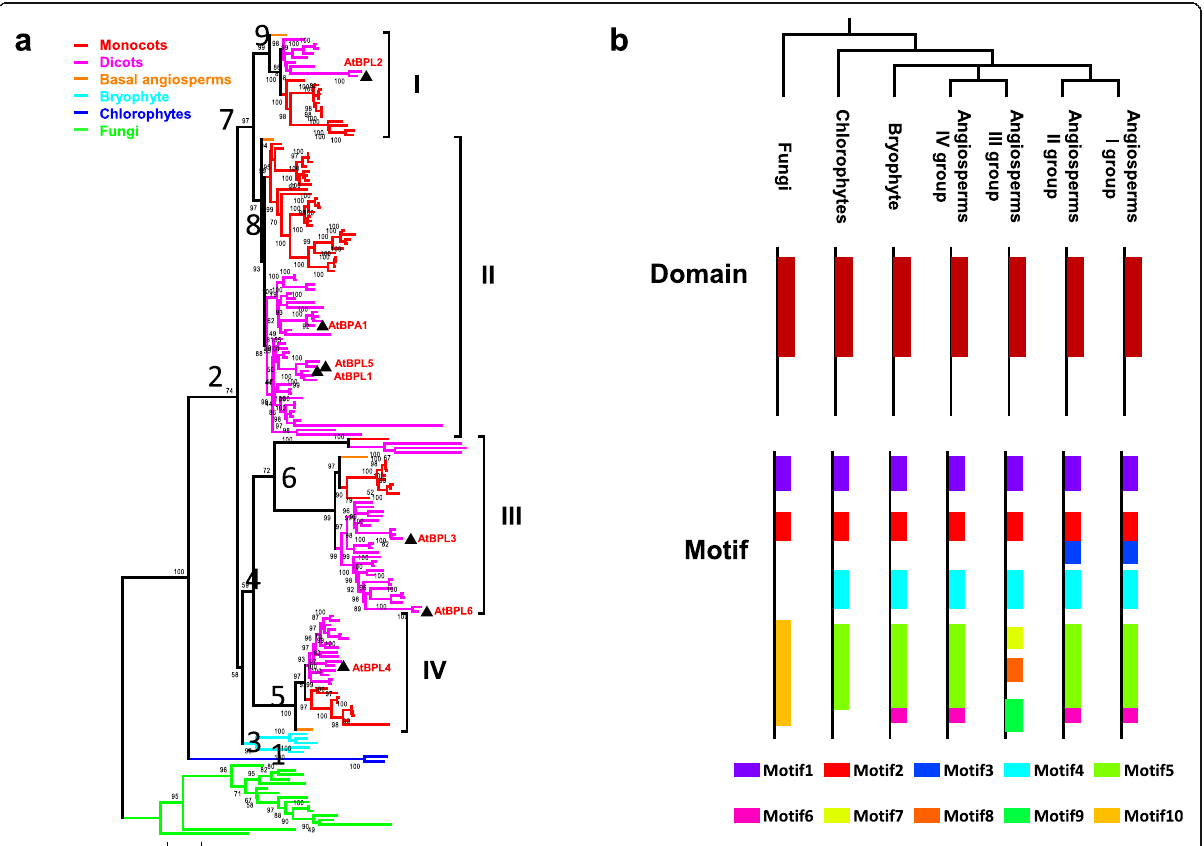
Fig. 3 The phylogenetic relationship of BPAs and their conserved motifs. a The maximum-likelihood phylogenetic tree of BPA sequences from representative species. Fungal sequences were used as the outgroup (green). Angiosperm BPAs were classified into four clades (I-IV). Red, purple, orange, aqua green or blue labels indicate proteins from monocots, dicots, basal angiosperms, bryophytes and chlorophytes, respectively. b Domain structures and conserved motifs in each clade/group. Motifs are distinguished by different colors as shown in the legend. Domain structures were predicted by scanning against the Pfam database (El-Gebali et al. 2019). Motifs were identified using MEME (Bailey et al.